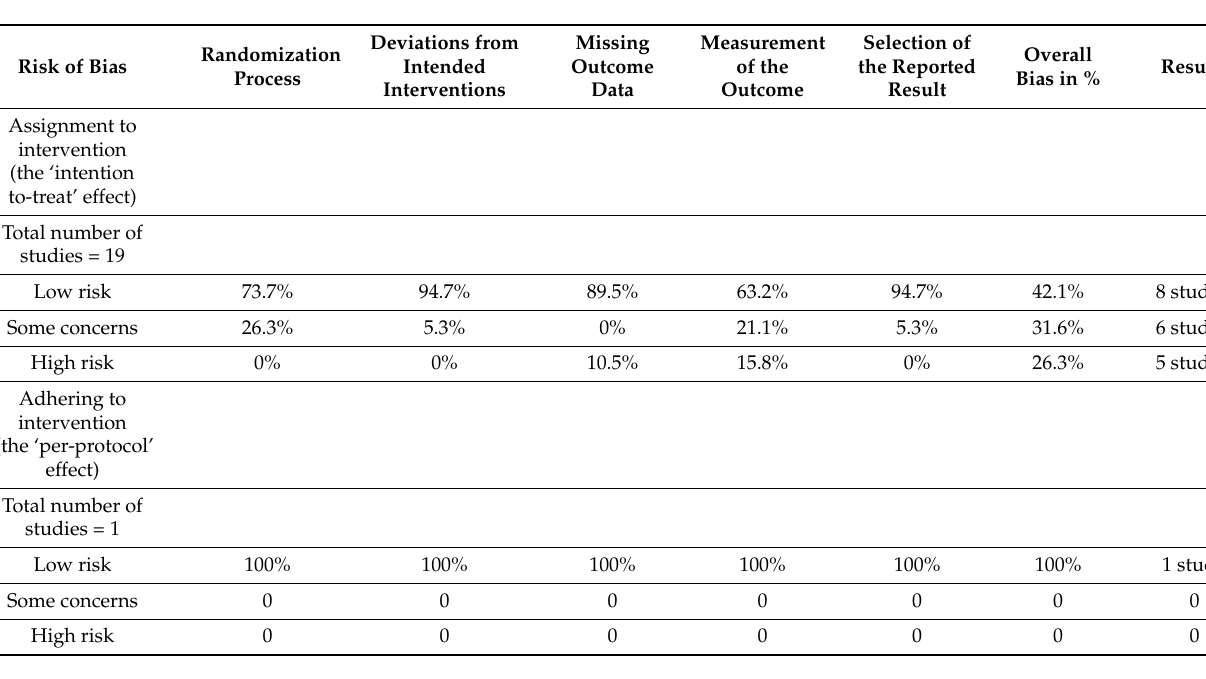
Table 2. Risk of